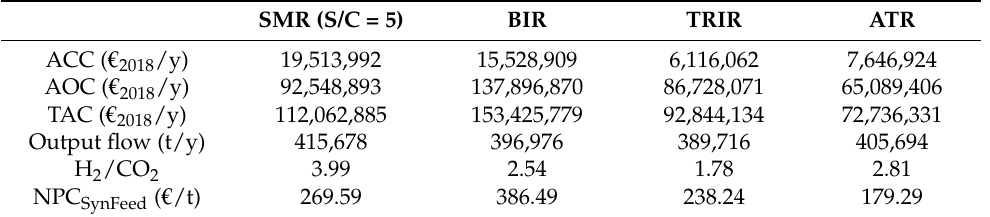
Table 16. Cost results for different reforming technologies (Case of 1000 kmol/h reformer gas